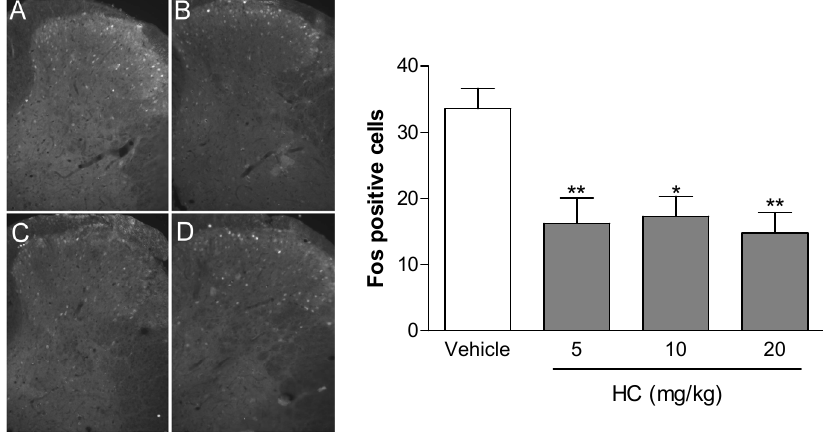
Figure 5. Immunofluorescence for Fos protein in the spinal cord dorsal horn, Ninety minutes after the intraperitoneal injection of vehicle ( A ) hecogenin acetate at doses of 5 ( B ), 10 ( C ) and 20 ( D ) mg/Kg. The bar graph shows (below and right side) average Fos positive cells compared with the vehicle-treated group (white bar) Values represent mean ± S.E.M. ( n = 6, per group). * p < 0.05, ** p < 0.01 vs. control (one-way ANOVA followed by Tukey’s